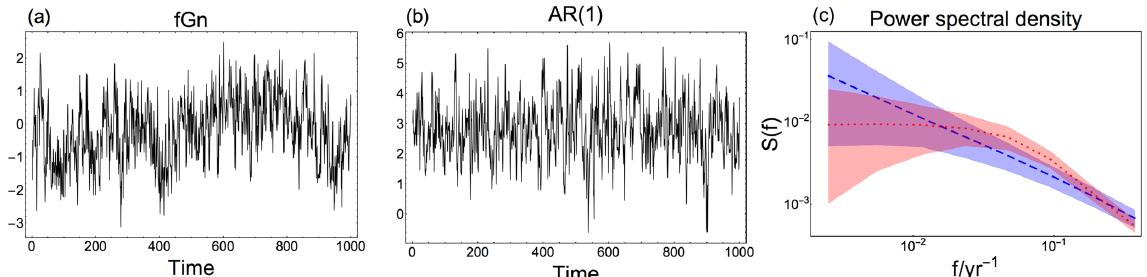
Figure 1. (a) Arbitrary fGn time series with β = 0 . 75. (b) Arbitrary time series of an AR(1) process with parameters estimated from the time series in (a) using maximum likelihood. (c) Log–log spectra showing 95% confidence ranges based on Monte Carlo ensembles of fGn with β = 0 . 75 (blue shaded area), and AR(1) processes with parameters estimated from the time series in (a) (red, shaded area). Dashed (dotted) lines mark the ensemble means of the fGn (AR(1)) process